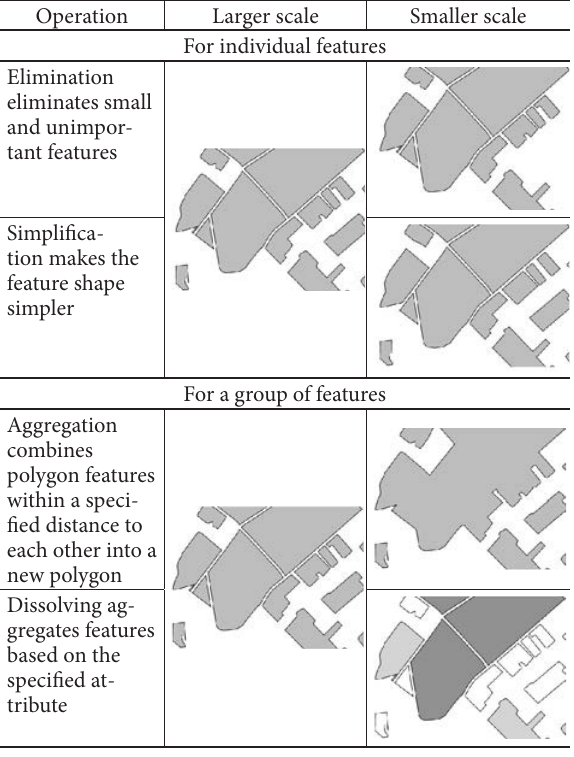
Table 1. Generalization operations for polygon features of land cover For individual